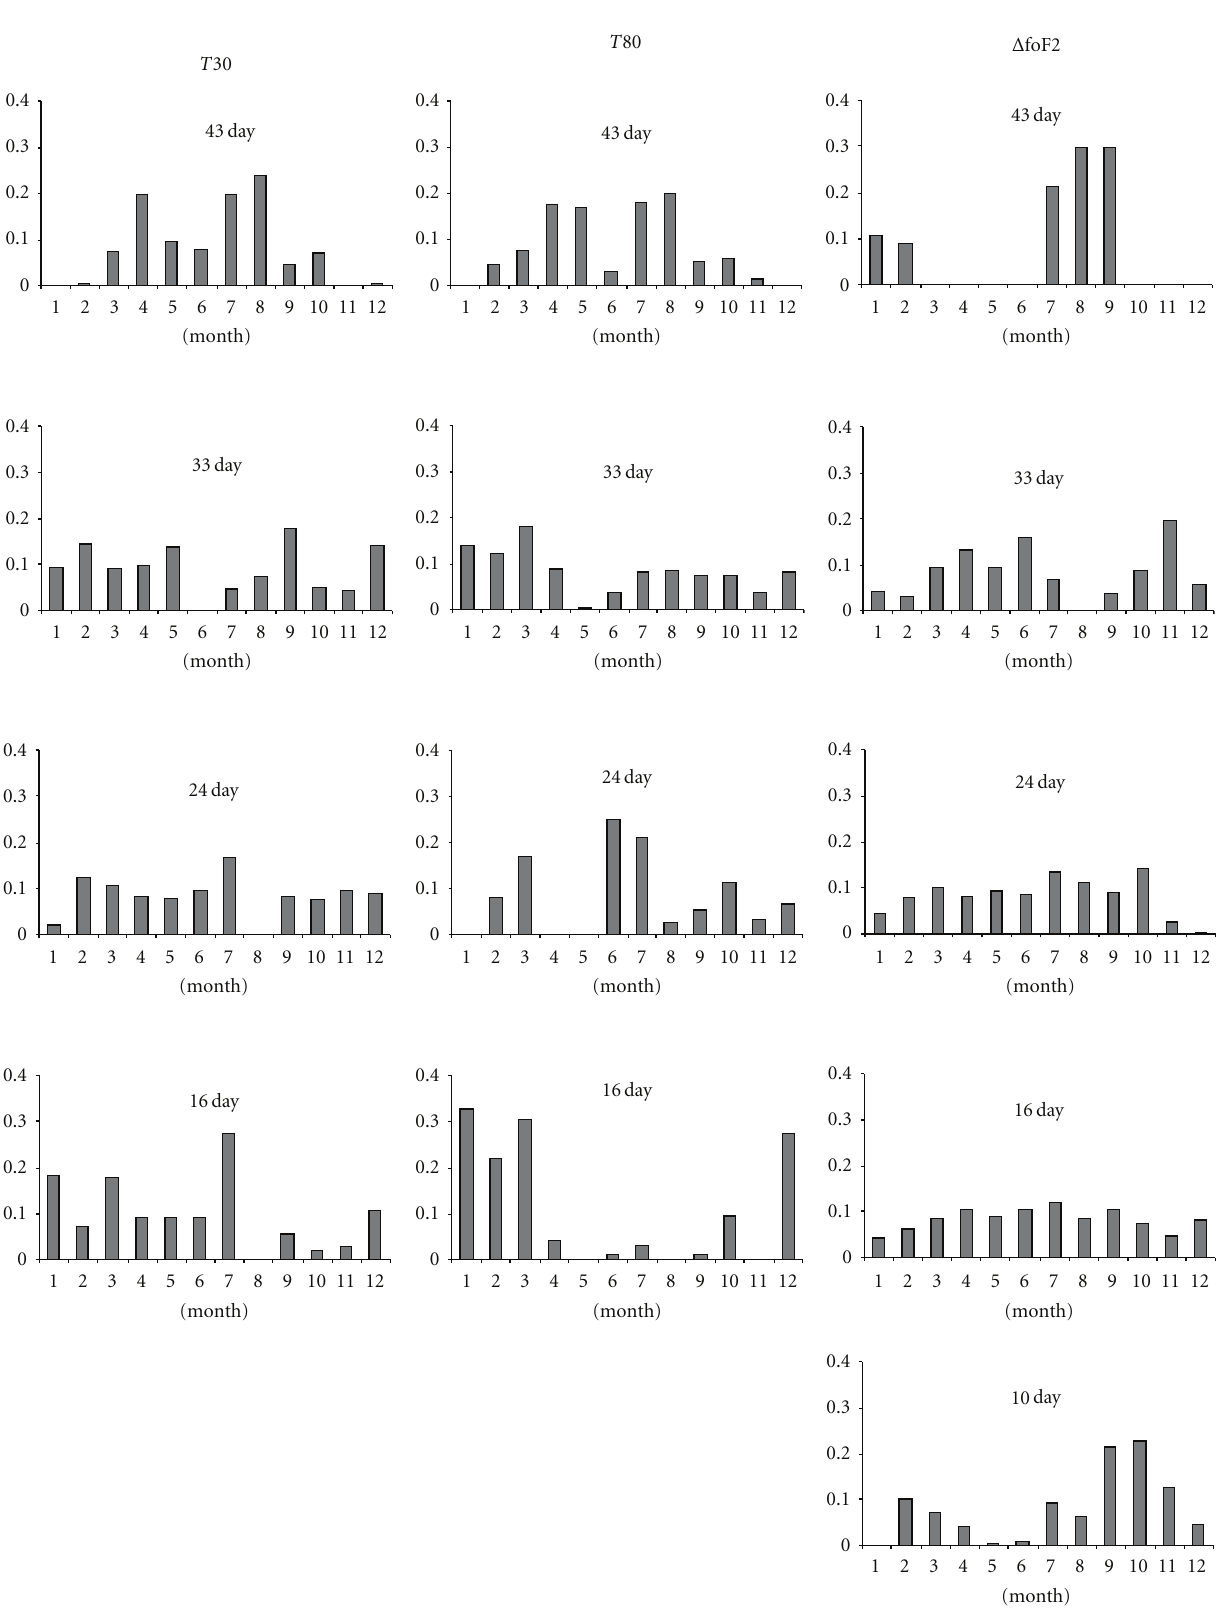
Figure 6: The seasonal dependence of the probability of wave occurrence: T30—in the stratospheric temperature, T80—in mesospheric temperature, Δ foF2—in critical frequency